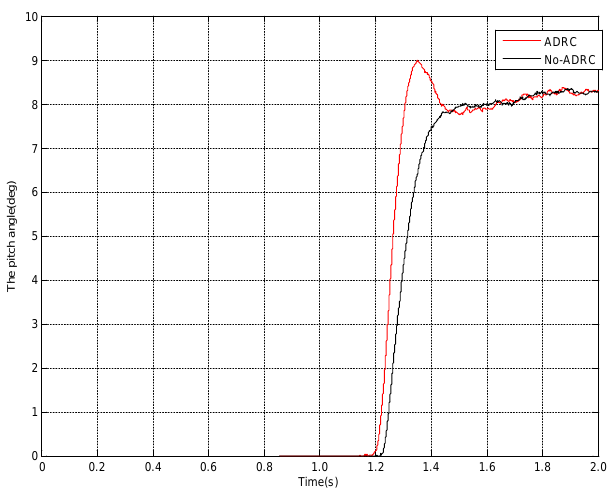
Table 5. Simulation results of pitch angle.